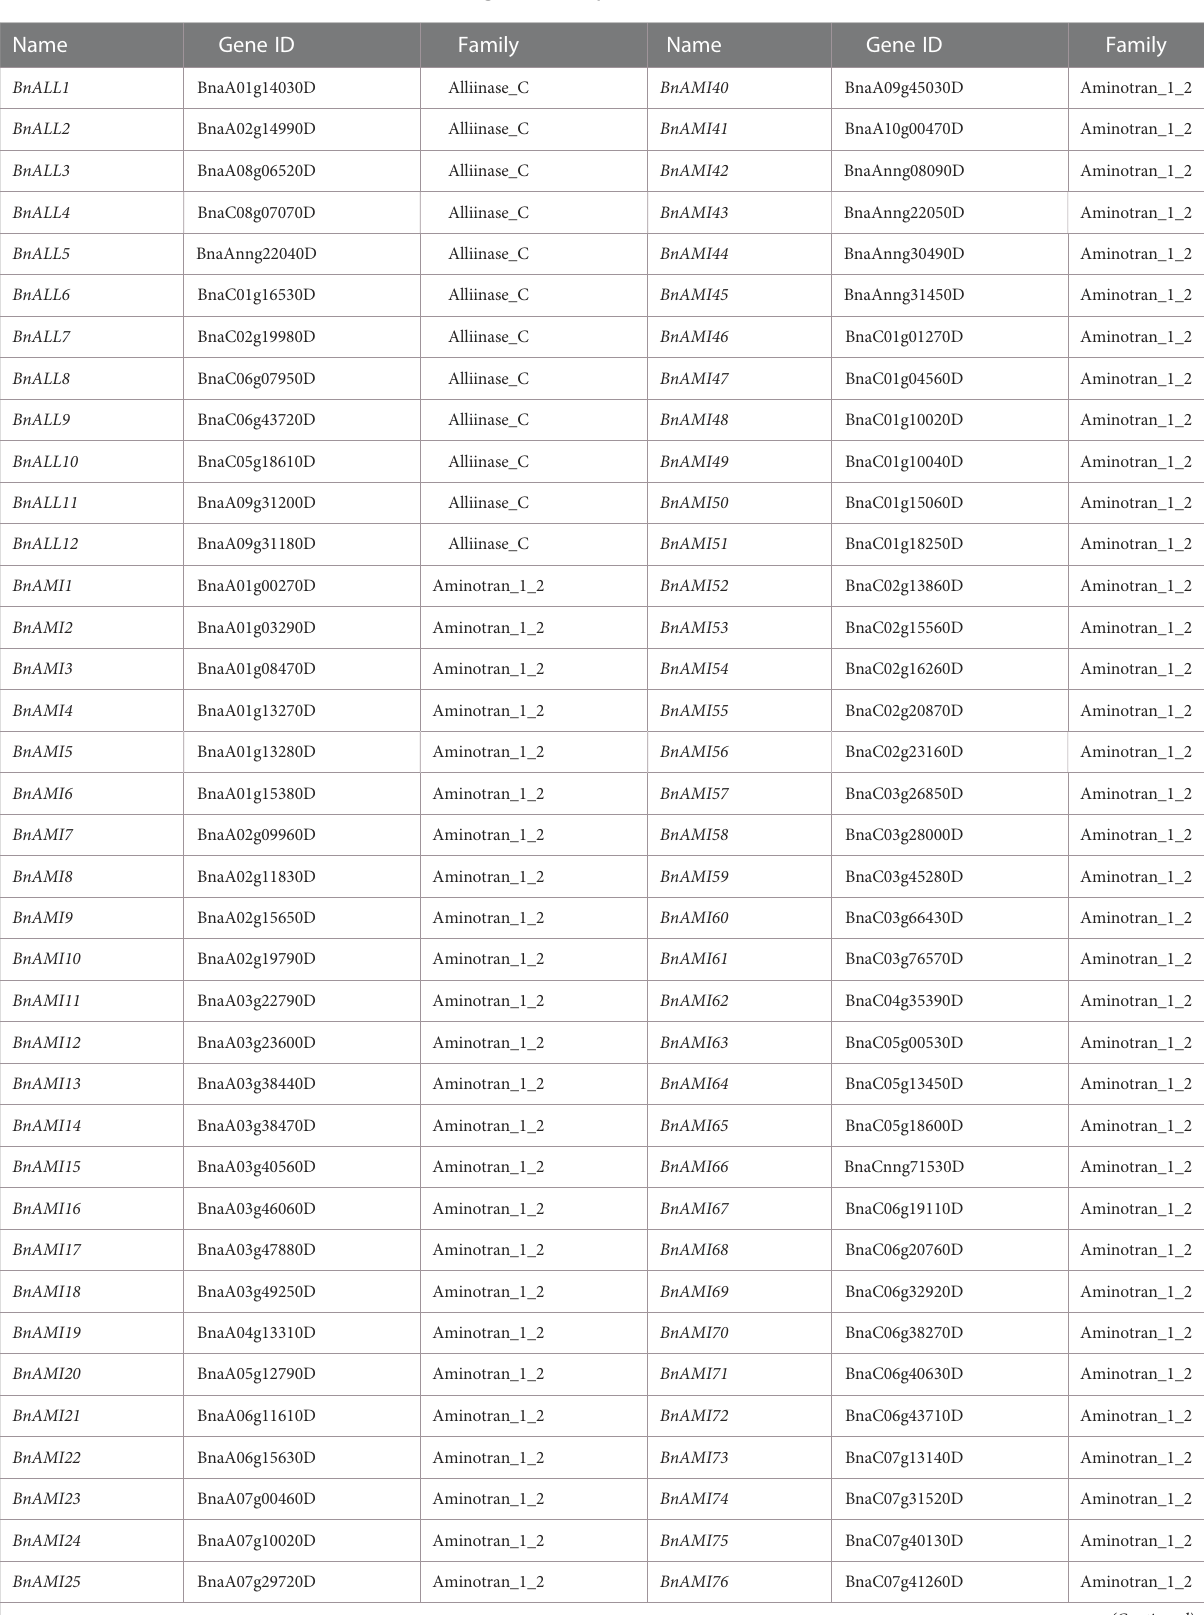
TABLE 1 Genome identi fi cation and classi fi cation of TAR s genes in B. napus